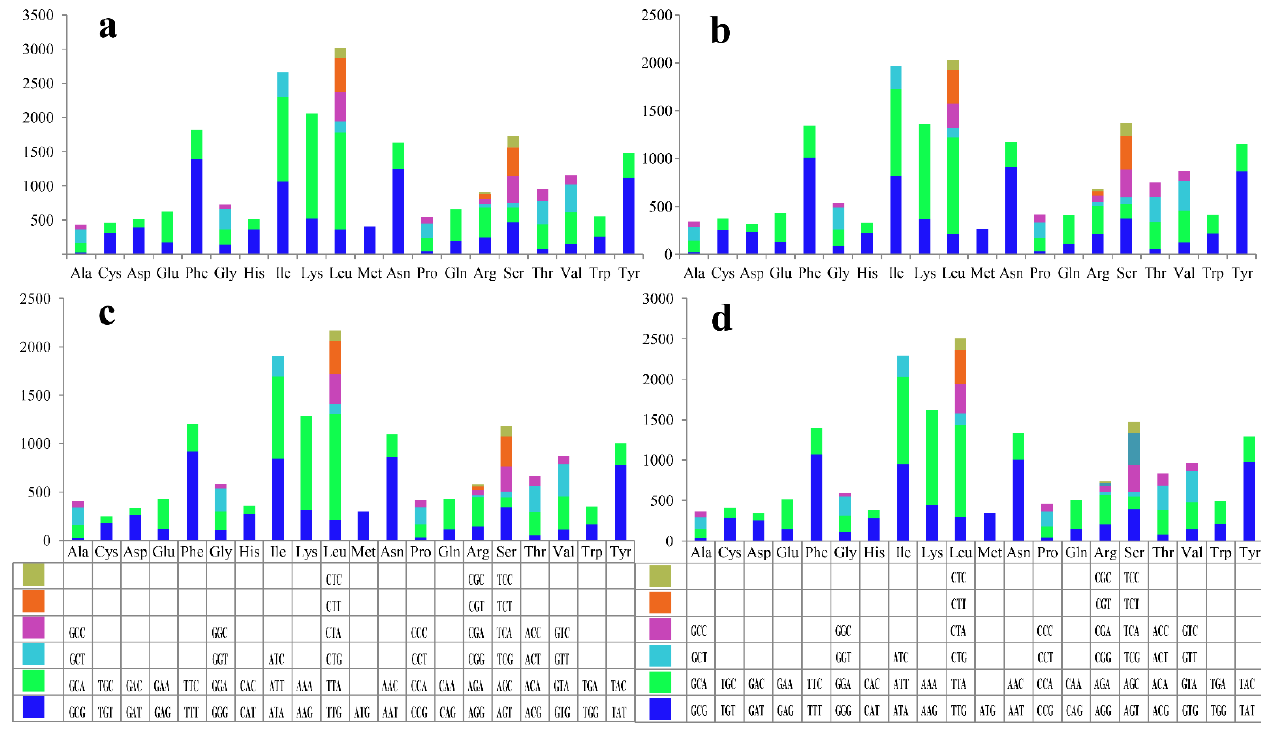
Figure 2. Codon usage analysis of the four newly sequenced Ganoderma mitogenomes: ( a ) G. subam- Figure boinense s118; ( b ) G. lucidum s37; ( c ) G. lingzhi s62; and ( d ) G. lingzhi s74.